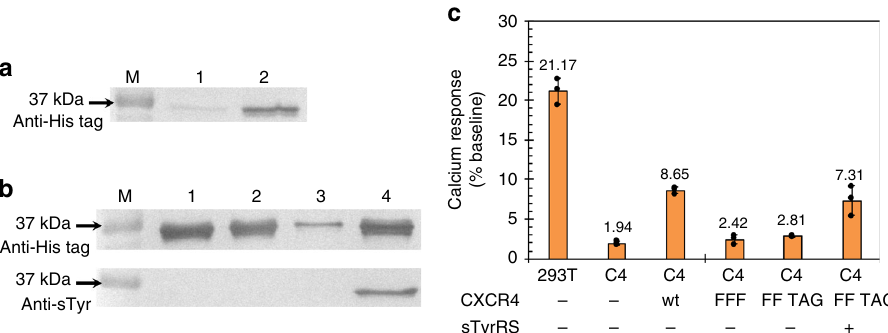
Fig. 4 Functional incorporation of sTyr in mammalian cells. a Western blot analysis of CXCR4(N38-21TAG)-EGFP expression in the absence (lane 1) and presence of sTyr (1 mM, lane 2) in 293T cells with psTyrRS. b Western blot analysis of partially puri fi ed CXCR4(N38)-EGFP variants. Lane 1, CXCR4(N38)- EGFP; lane 2, CXCR4(N38-FFF)-EGFP; lane 3, CXCR4(N38-FF 21TAG)-EGFP in the absence of sTyr; lane 4, CXCR4(N38-FF 21TAG)-EGFP in the presence of sTyr (1 mM); c Calcium mobilization assay. wt, wild-type CXCR4; FFF, CXCR4(FFF) mutant; FF TAG, CXCR4(FF 21TAG) mutant. Lane M in both ( a ) and ( b ) is molecular weight marker. c Data are plotted as the mean ± s.d. from n = 3 independent experiments. a – c Source data are provided as a Source data fi